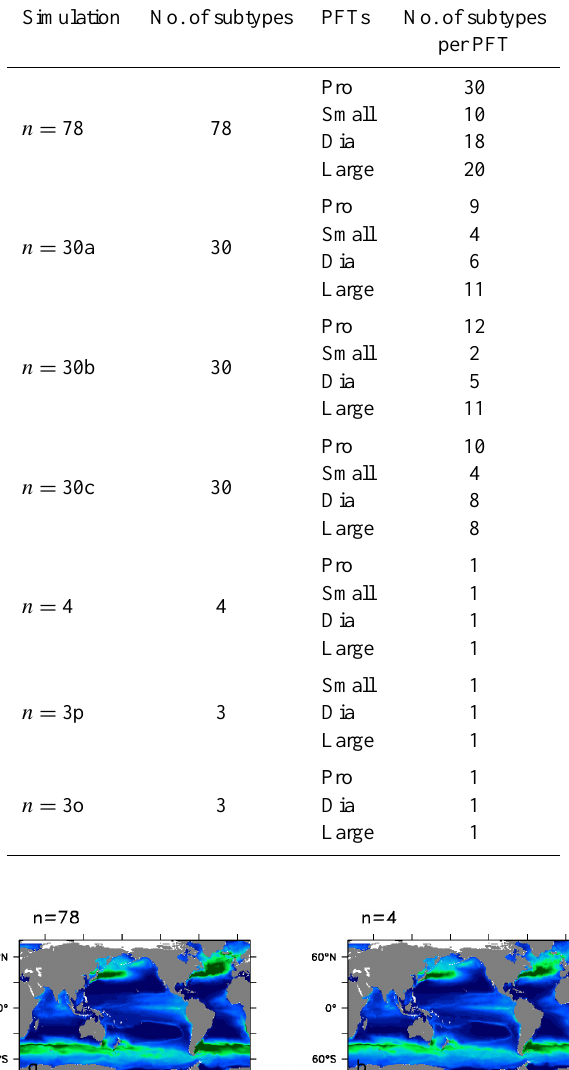
Table 1. Simulations with plankton functional types (PFTs; Pro: Prochlorococcus; Small: other small; Dia: diatoms; Large: other large) and number of subtypes in each PFT.